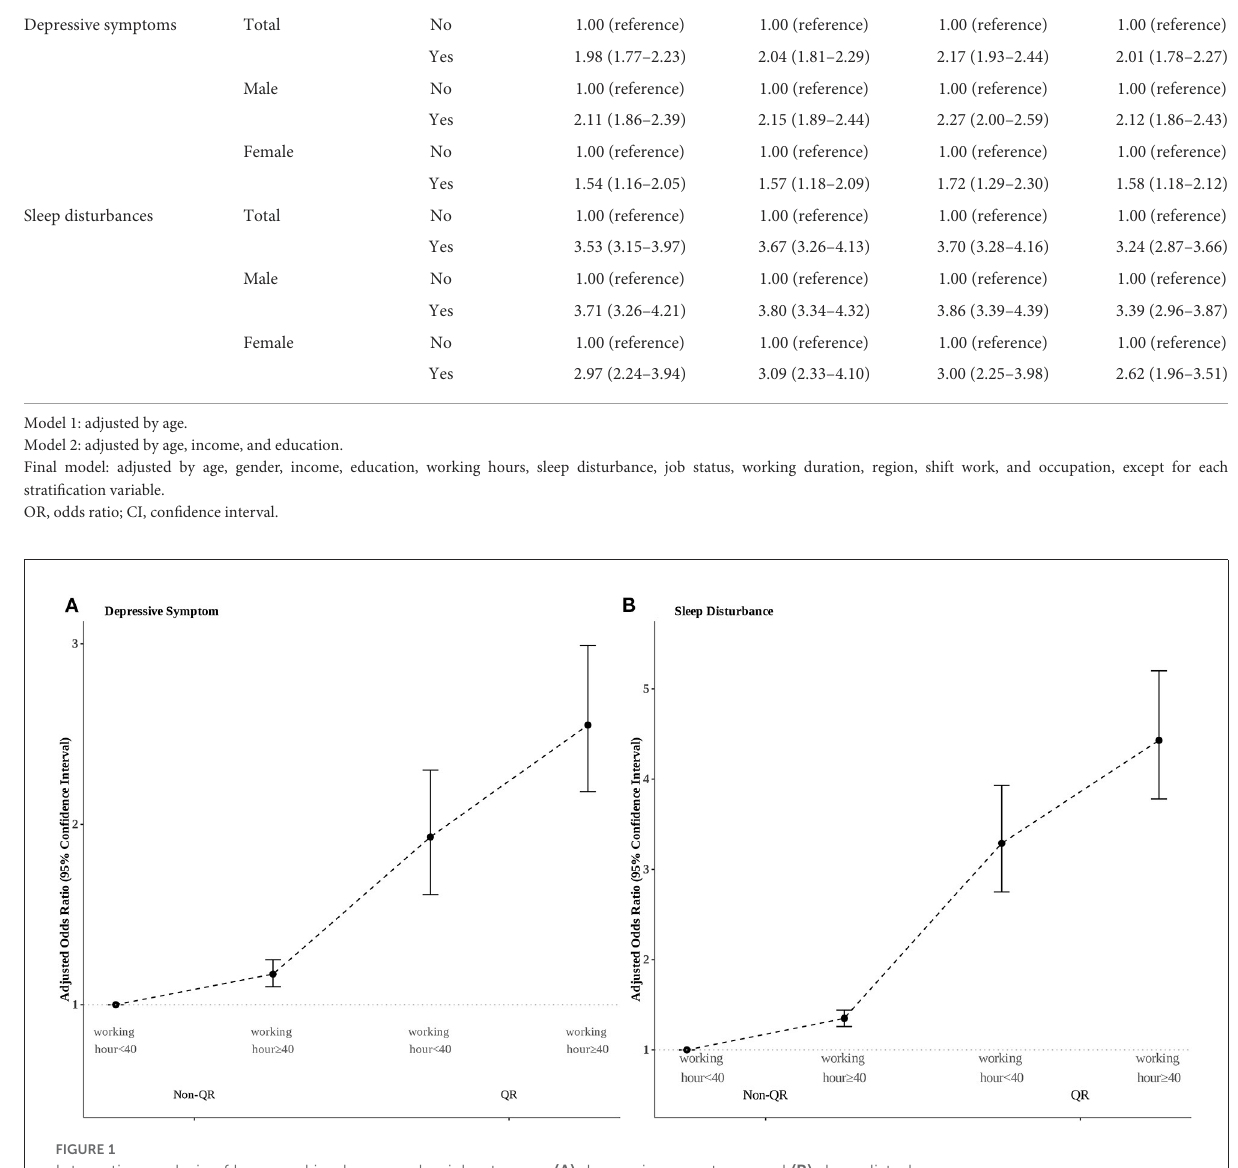
TABLE 2 Adjusted ORs (95% CIs) of depressive symptoms and sleep disturbance by quick return with stratification of gender in a logistic regression model. Gender Quick return Crude model Model 1 Model 2 Final model Depressive symptoms